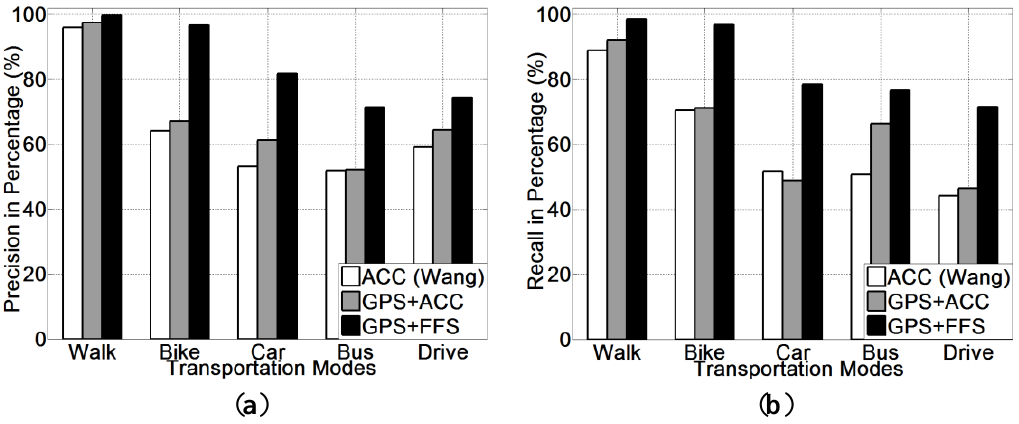
Figure 12. Transportation mode recognition results using decision table: ( a ) precision; ( b )